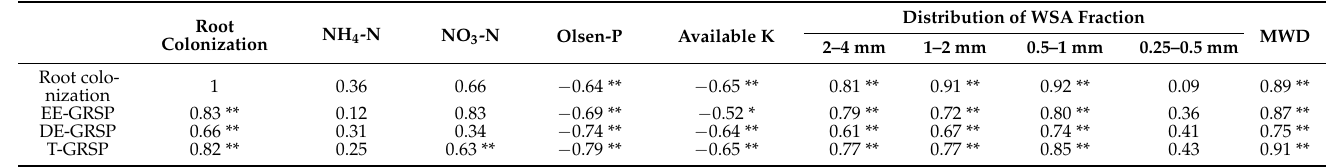
Table 6. Pearson’s correlation coefficient ( r ) between glomalin-related soil protein fractions and soil properties.